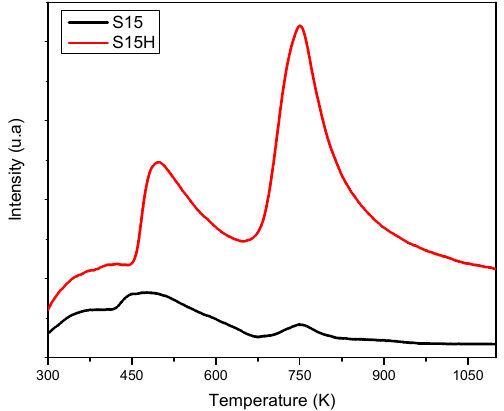
Figure 10. NH 3 thermal programmed desorption from silica specimens (TPD-NH 3 ) analysis of the S15 precursor solid as well as for the S15H hydroxylated material following thermo-alkaline treatment.